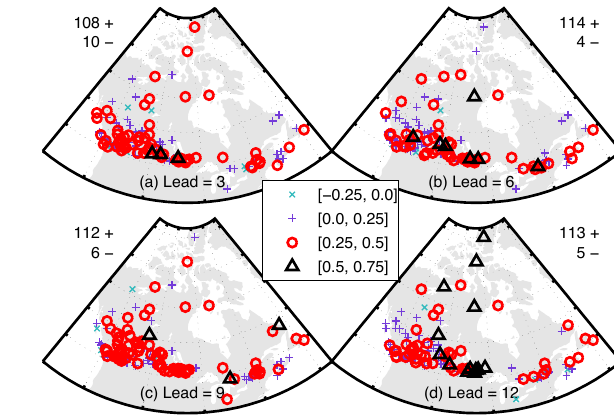
Fig. 10. Difference between the forecast correlation skills of the SVR-R model and that of the MLR model at lead times of (a) 3, (b) 6, (c) 9 and (d) 12months. The two numbers beside each panel give the number of stations where the SVR-R correlation is higher (lower) than that of the MLR model, as indicated by the + ( − )